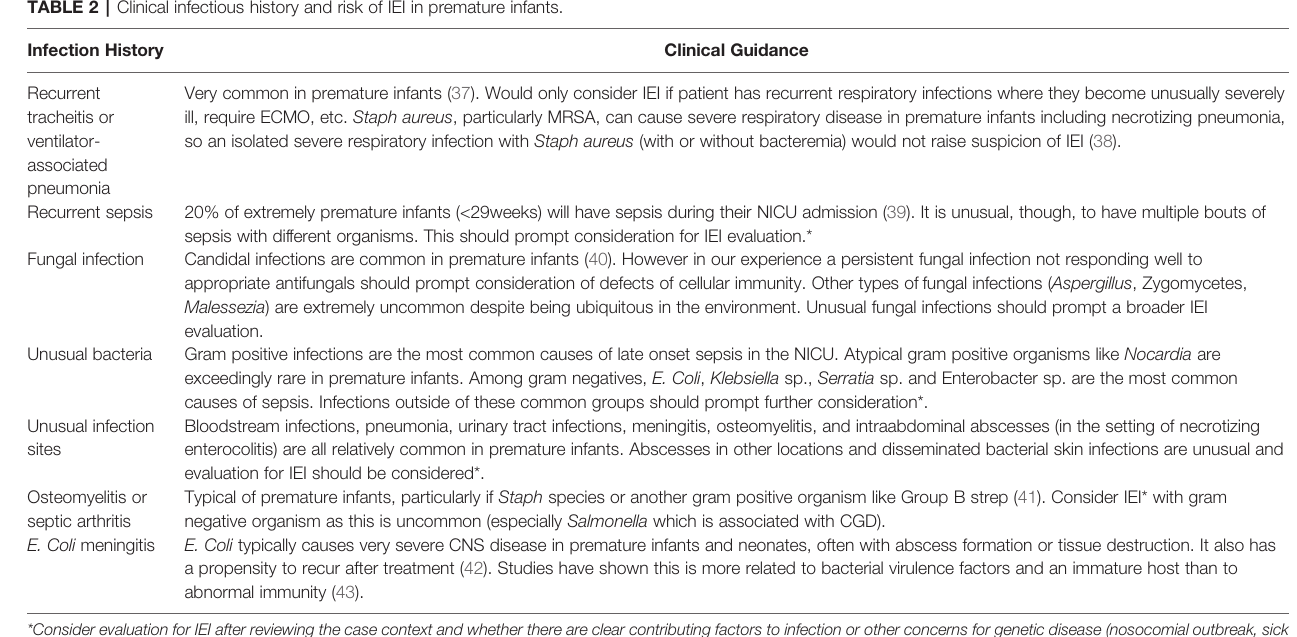
TABLE 2 | Clinical infectious history and risk of IEI in premature